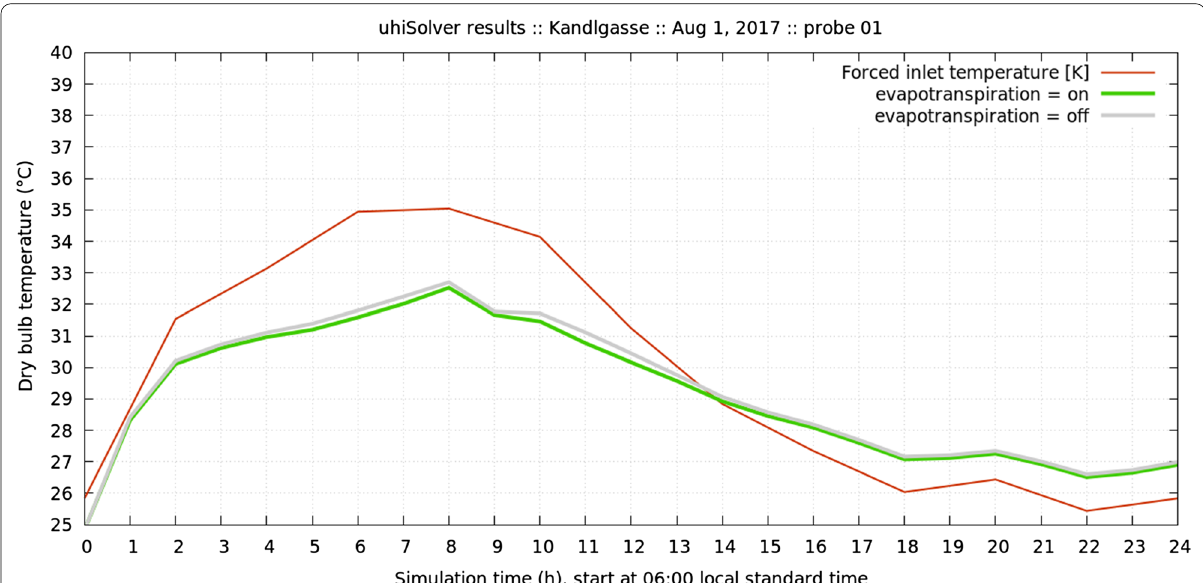
Fig. 12 Temperature profiles of probe 01 with (green line) and without evapotranspiration (grey line) compared to the forced inlet temperature (red line)